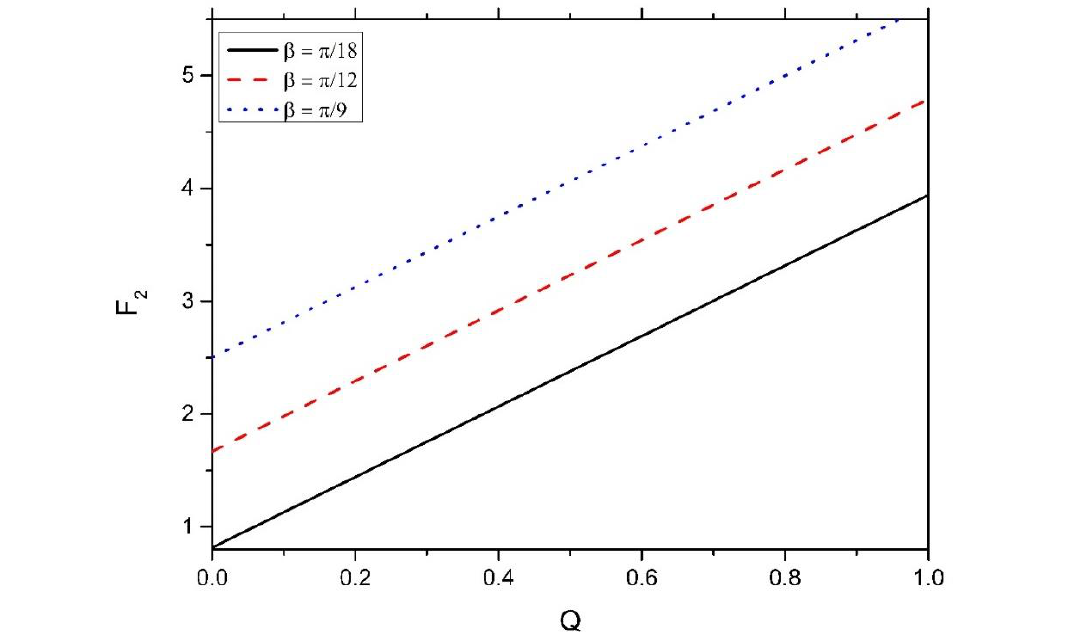
N = 0.5, N = 0.1,  = 0.1,, Br = 0.2,  =0.1, b t  = 0.01. 1